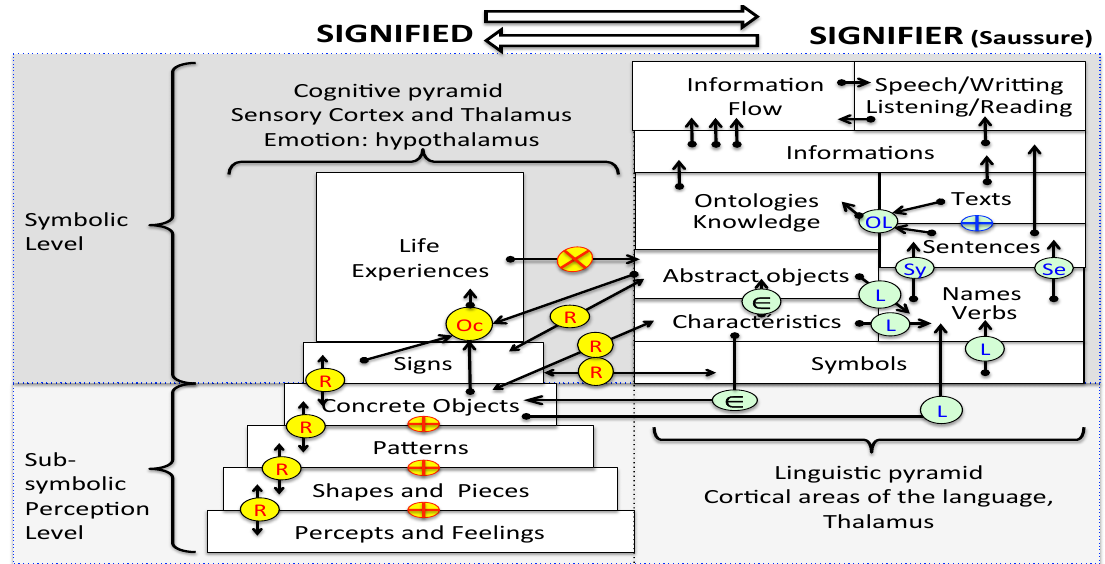
Figure 17. The cognitive pyramid